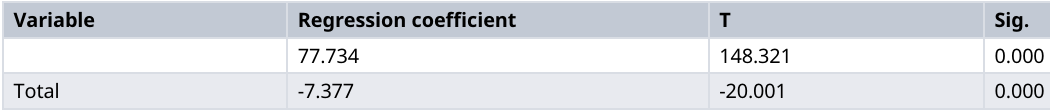
Table 5. Linear regression analysis on parents ’ knowledge towards children ’ s OHI-S